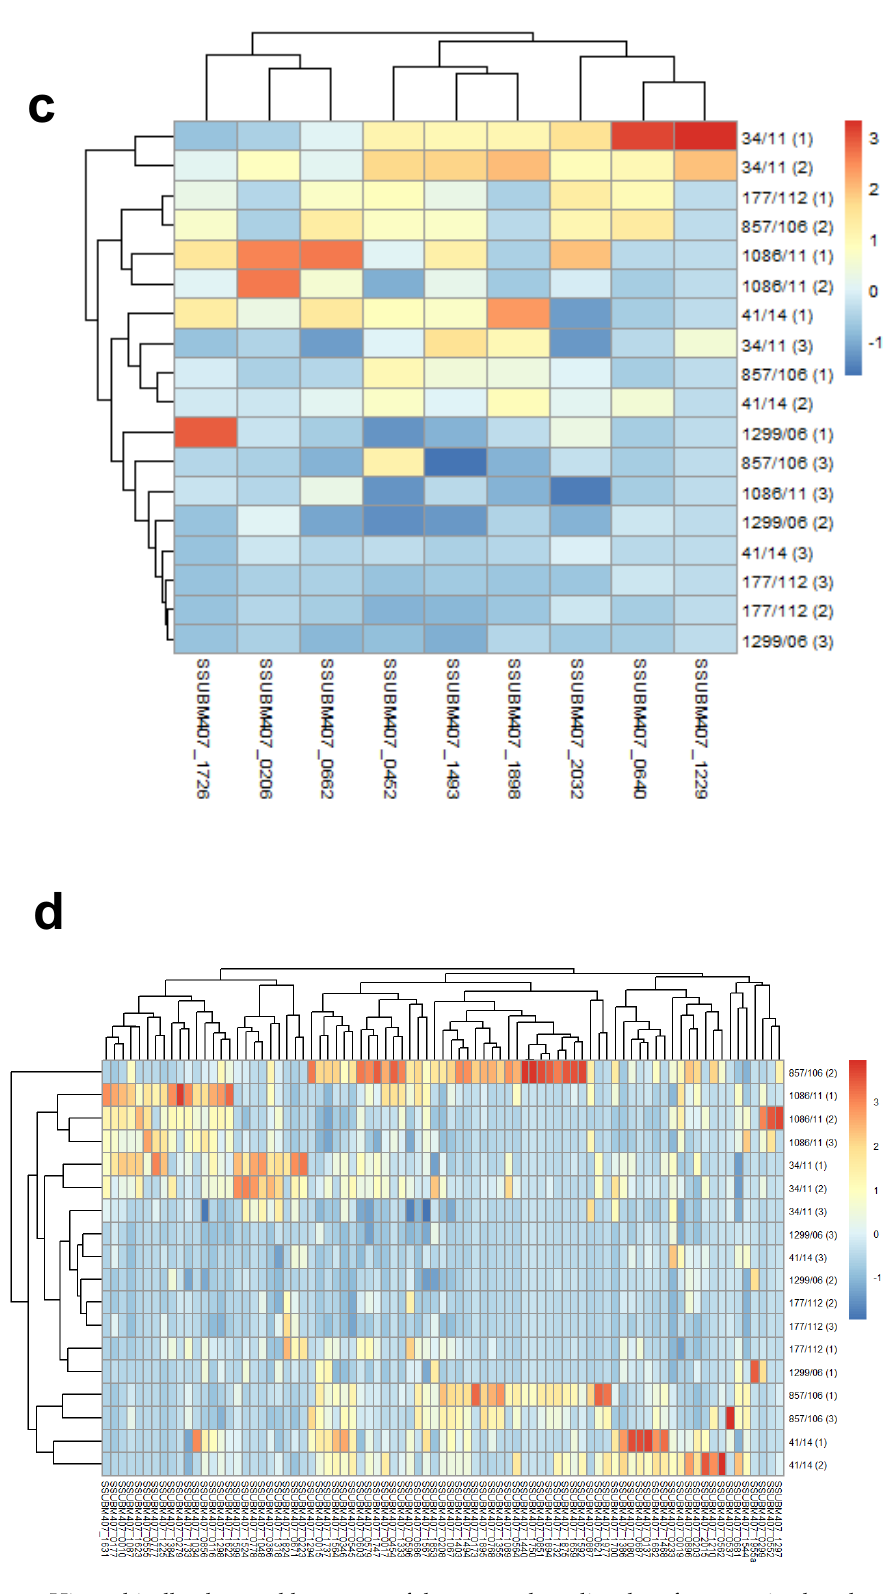
Figure 2. Hierarchically-clustered heatmaps of the z-scored predicted surface protein abundances in the six Streptococcus suis human clinical isolates: ( a ) lipoproteins, ( b ) cell wall proteins, ( c ) secreted proteins, ( d ) membrane proteins. The proteins are clustered in columns in each heatmap, and the isolates are shown in rows. The numbers in parenthesis in clinical isolates representing each of the three biological replicates.